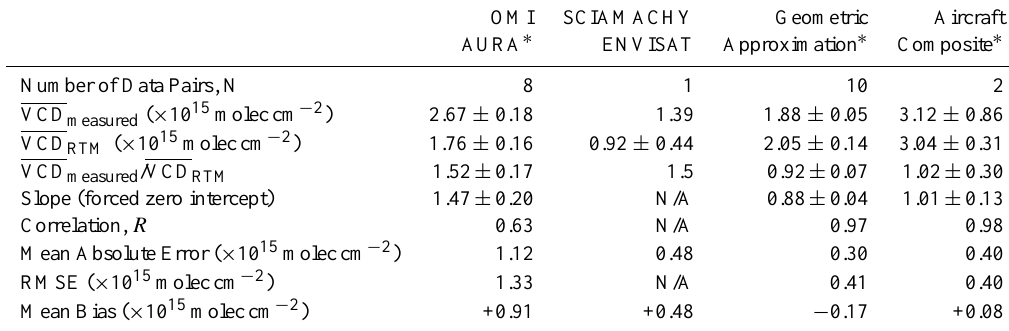
Table 2. Comparison of various NO 2 VCDs to the values of VCD RTM